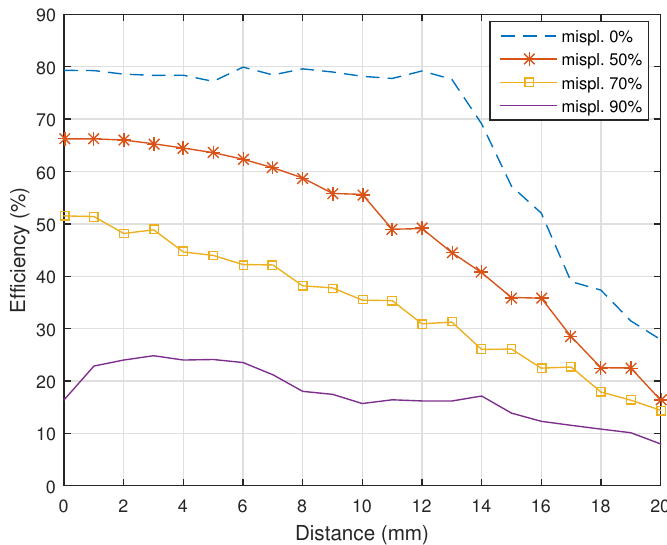
Figure 16. Measured misalignment efficiency of the combined system for various positions of the receiver.